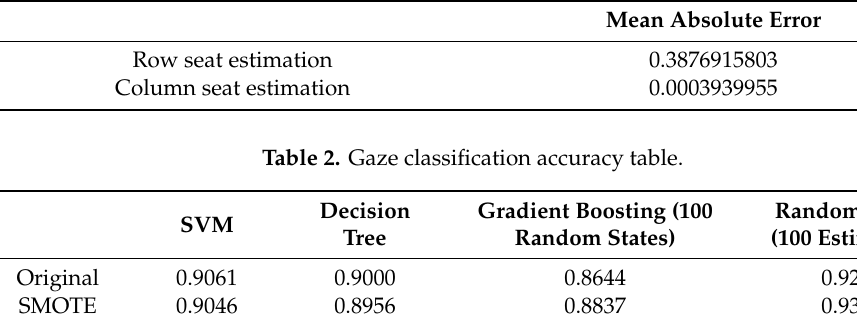
Table 1. Mean absolute error (MAE) of position estimation.